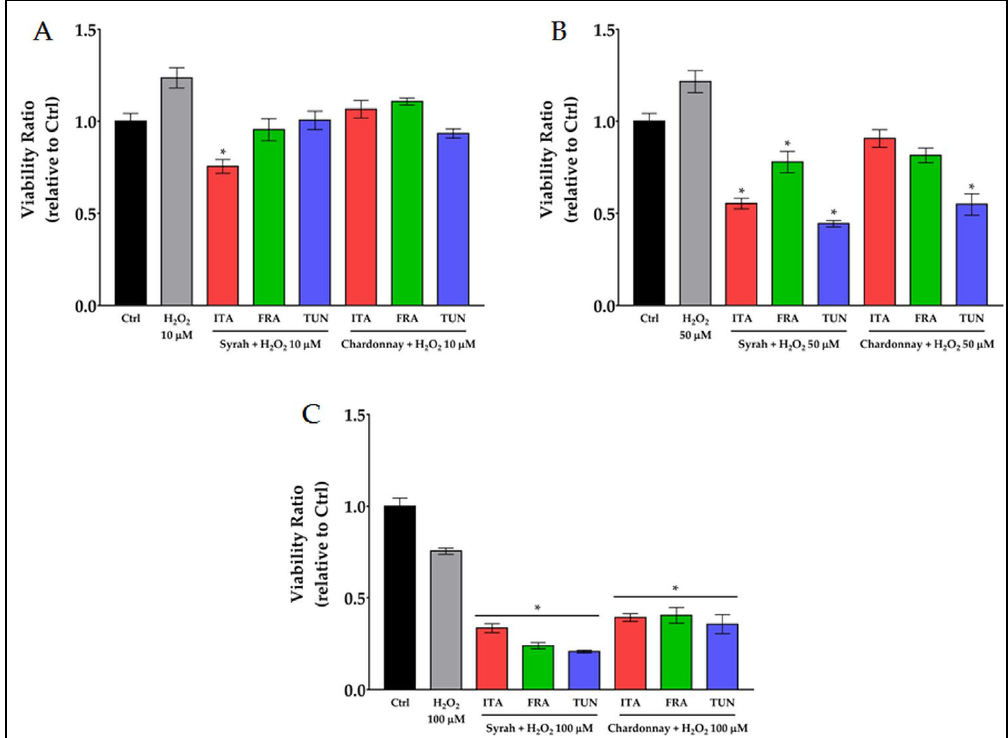
Figure 4. Prooxidant activity of 24 h combined treatments with 250 µg/mL pomace extracts and low concentrations (10, 50, and 100 µM, subfigure A, B and C respectively) of H 2 O 2 on B16F10 cancer cell. * = p ≤ 0.01 vs . H 2 O 2 .